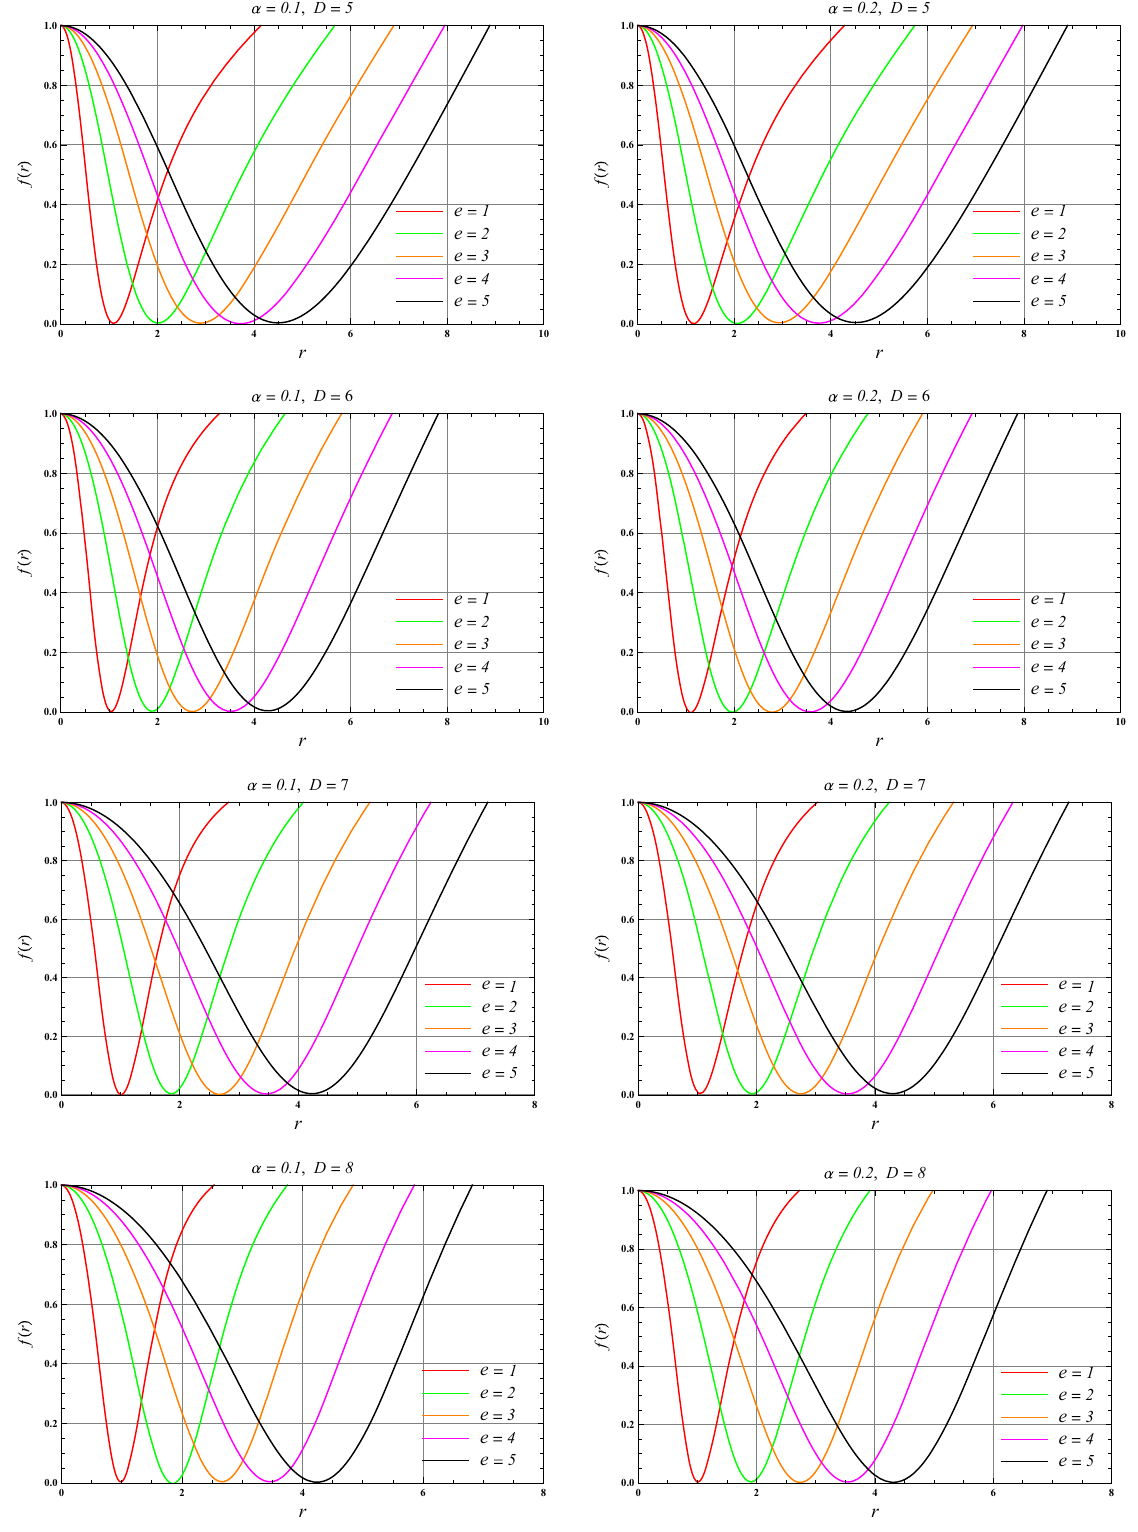
Fig. 6 Plot of metric function f ( r ) vs radius r in various dimensions D = 5, 6, 7, and 8 (top to bottom) for different values of charge e with Gauss–Bonnet coupling parameter α = 0 . 1 and 0.2 (left to right) with μ (cid:9) =